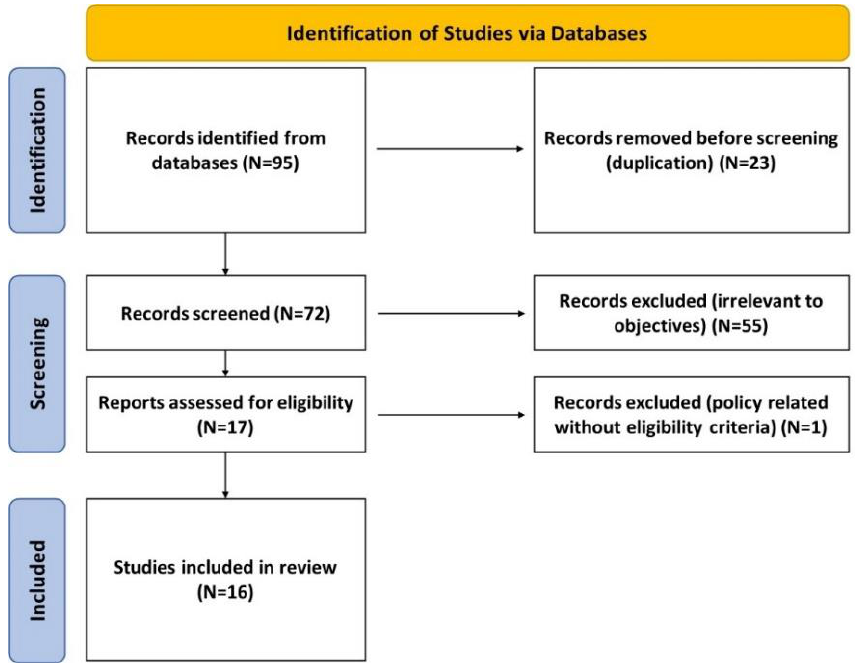
Figure 1. PRISMA flowchart.